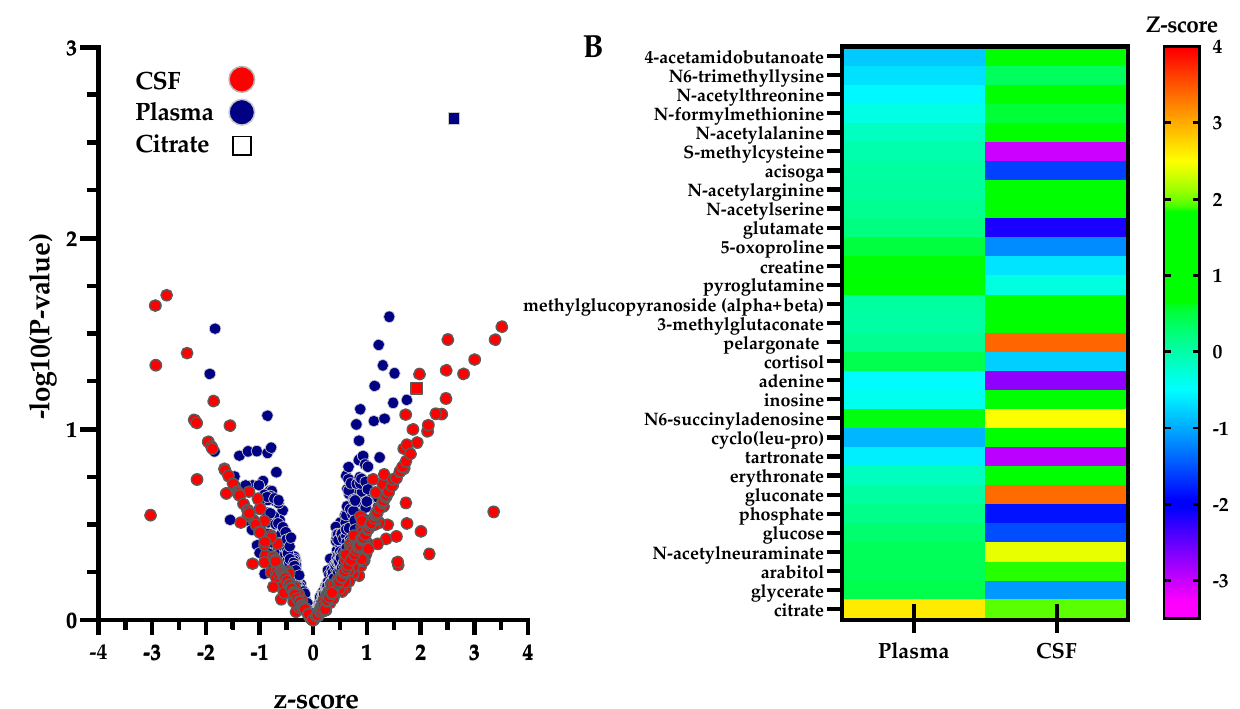
Figure 4. Comparison of Metabolites in Human Biofluids Illustrates Significant Alterations Between Plasma and CSF. ( A ) Metabolomic profiles of SLC13A5 deficiency in plasma and CSF are shown. Metabolites present in plasma ( n = 8, blue-filled circles) and cerebrospinal fluid (CSF) ( n = 3, red-filled circles) obtained from individuals with SLC13A5 deficiency (see Methods) are illustrated in a volcano plot. Citrate is indicated as a square for each biofluid for ease of identification. ( B ) Compartmental differences between plasma and CSF suggest altered metabolic flux. Molecules significantly altered in CSF compared to plasma are illustrated in a heat map ( p < 0.05 Student’s t -test) to highlight compartmental differences in the flux of these molecules. Citrate, elevated in both biofluids, is included in the heatmap; however, citrate flux is not significantly different between plasma and CSF. Molecules not identified in both biofluids were not assessed for flux. See Supplementary Data, Table S5.